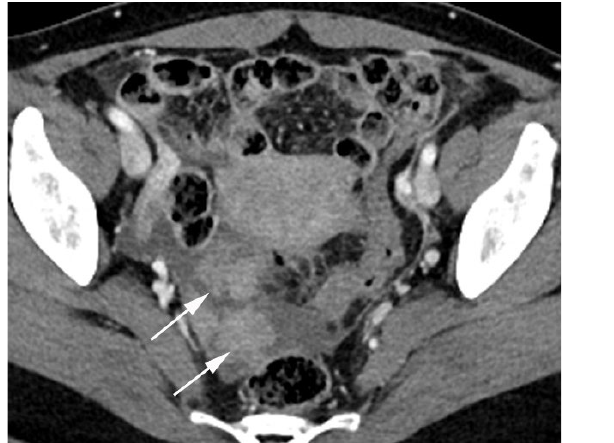
Figure 2. Serous borderline ovarian tumor in a 27 ‐ year ‐ old woman. ( A ) Contrast ‐ enhanced axial CT shows a unilocular cystic mass (*) with an ill ‐ defined solid component (arrows) in the right ovary. ( B ) Microscopically, tumor cells present nuclear atypia and cellular proliferation without stromal invasion (hematoxylin and eosin 40×).